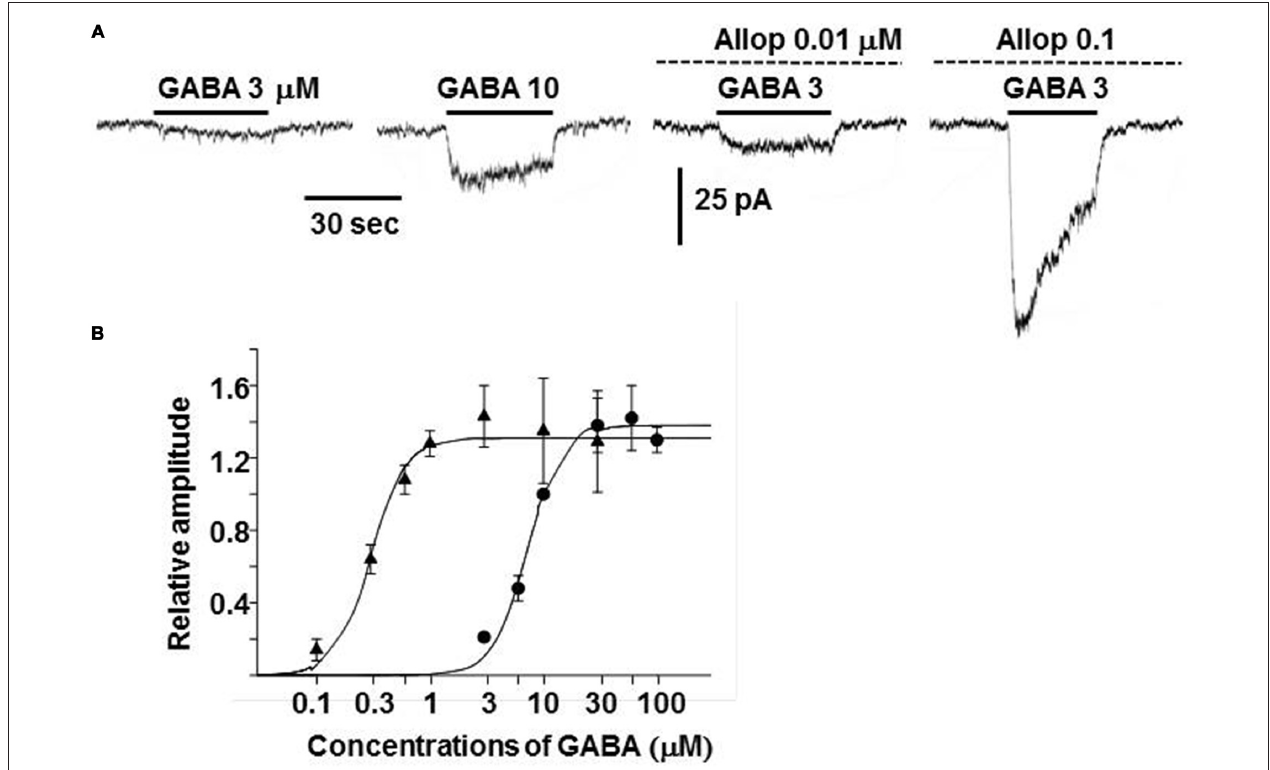
FIGURE 5 | Enhancement of GABA A receptor channel activity by allopregnanolone. (A) Whole-cell currents recorded from a dissociated guinea-pig chromaffin cell at − 60 mV. The traces were obtained from the same cell. GABA at 3 or 10 µ M was bath applied during the indicated period (bars) in the absence and presence of 0.01 or 0.1 µ M allopregnanolone (interrupted lines). (B) Dose-response curves for GABA-induced currents at the plateau level in the absence ( • ) and presence ( (cid:78) ) of 0.1 µ M allopregnanolone. The lines show fits of logistic equations with I Max s of 1.38 and 1.31, slope factors of 2.88 and 2.83, and EC 50 s of 7.2 and 0.3 µ M in the absence and presence of allopregnanolone, respectively. Plateau amplitudes of GABA-induced currents are expressed as fractions of those of 10 µ M GABA currents in the same cells. The data represent mean ± SEM. (A,B) Are reproduced from Inoue et al. (2013).